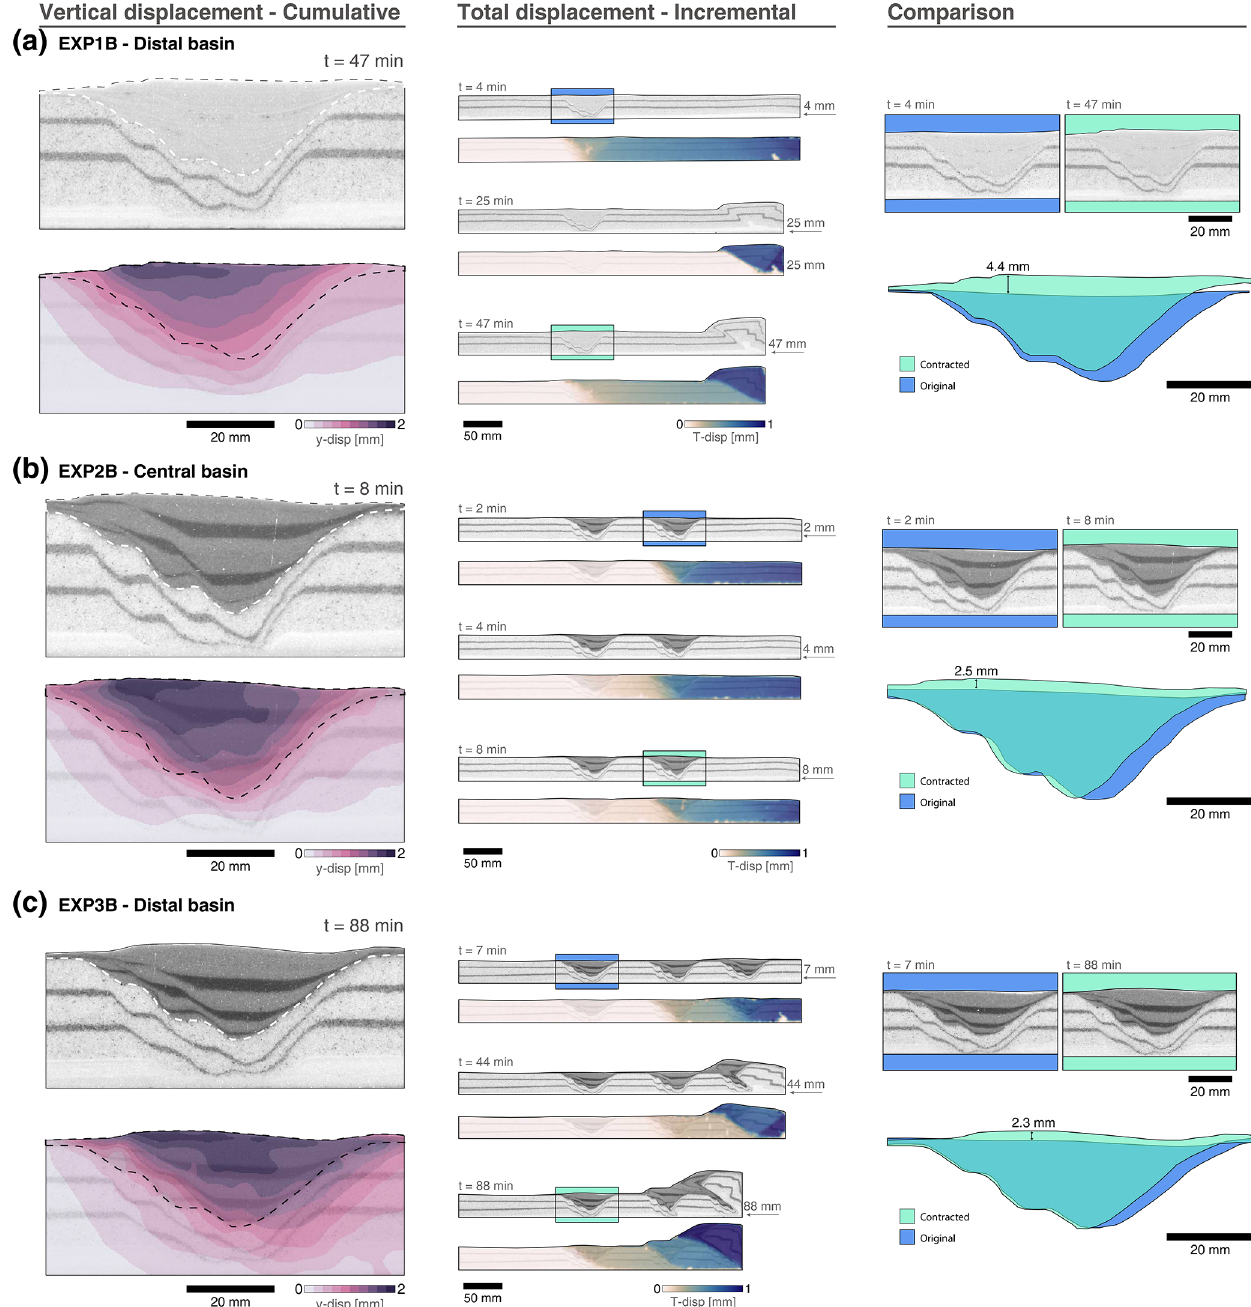
Figure 9. Close-up view of selected basins. In EXP2B, despite having only two basins, the basin closest to the moving wall is referred to as “central” for ease of comparison between experiments. The left panel shows Y displacement (vertical) before crustal failure, the central panel shows total displacement at the indicated time intervals, and the right panel is a drawn comparison between the original basin and its status before thrust